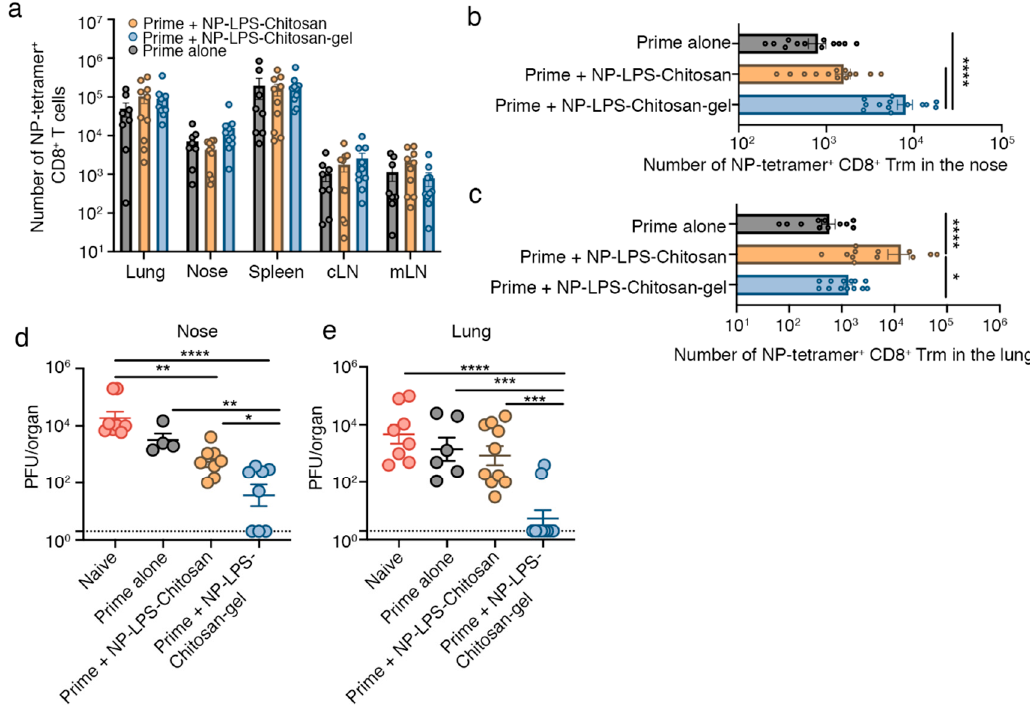
Figure 3. Intranasal immunization with an influenza virus nucleoprotein (NP)-peptide-loaded chitosan-hydrogel vaccine results in the development of nasal Trm that are protective against influenza virus infection. ( a – c ) Mice were primed by intraperitoneal injection of 10 6 PFU of influenza A virus A / Puerto Rico / 8 (H1N1) (PR8) strain of influenza virus, and 7 and 14 days later, boosted intranasally with either saline (Prime alone), NP-LPS-chitosan, or NP-LPS-chitosan gel. The absolute number of ( a ) total NP 366 -tetramer + CD8 + T cells in the lung, nose, spleen, cLN and mLN and the absolute number of CD103 + CD69 + Trm NP 366 -tetramer + CD8 + T cells in the ( b ) nose and ( c ) lung was measured 30 days after the initial prime. Data pooled from three independent experiments. Symbols represent individual mice, bars represent the mean + SEM ( n = 13–14 mice per group; one way ANOVA, Tukey’s multiple comparison) ( d , e ) Mice immunized as described above were challenged 28 days after the final boost with 10 4.5 PFU of X31(H3N2) via an upper respiratory tract infection and, three days later, the viral titres in the ( d ) nasal tissue and ( e ) lung were determined. Data pooled from three independent experiments. Dots represent individual mice, lines represent the mean + SEM ( n = 6–10 mice per group; one-way ANOVA, Dunnett’s multiple comparison). * p < 0.5, ** p < 0.01, *** p < 0.001, **** p < 0.0001